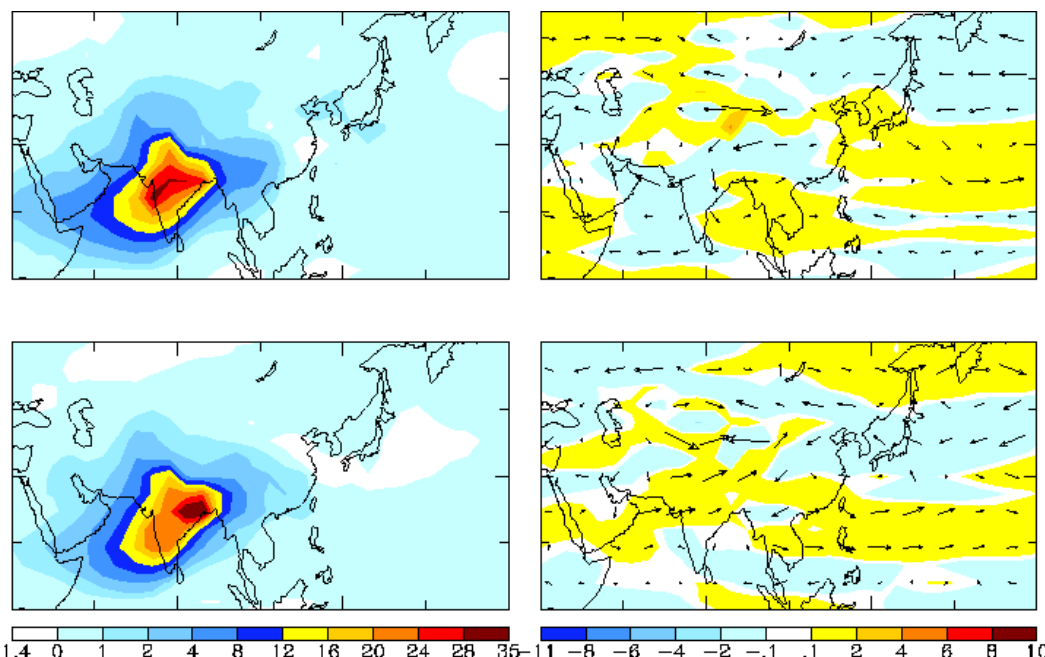
Fig. 9. Differences in annual average black carbon aerosols (0.1µgm − 3 ) from fossil and bio-fuel sources (left panel) and wind fields (ms − 1 ) at 630hPa (right panel). The top panels represent differences due to black carbon used in the Beig and Bond emissions for present-day (Year 2000) and the bottom panels represent future changes (from 2000 to 2010) from black carbon for the Beig emissions.